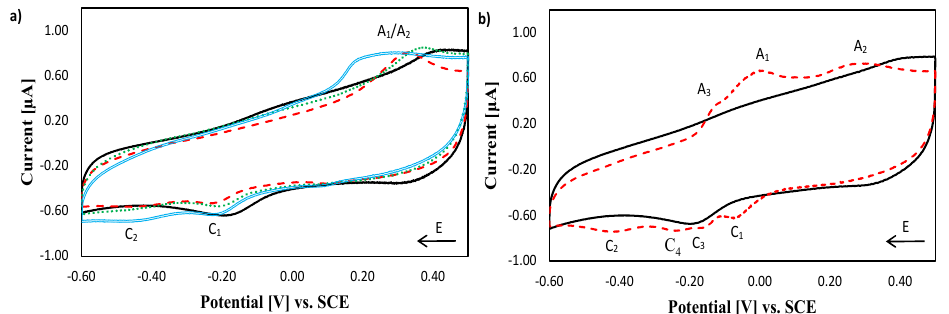
Figure 1. Typical cyclic voltammograms registered in O 2 -free solutions at the bare gold electrode, scan rate 100 mV s − 1 , in 0.1 M PB, pH 7.0 (black solid trace): ( a ) 20 µ M of [Cu(TPMA)(phen)] 2+ (red dashed trace), [Cu(TPMA)(bipy)] 2+ (blue double trace) and [Cu(TPMA)(DPQ)] 2+ (green dotted trace), ( b ) 20 µ M of [Cu(TPMA)(PD)] 2+ (red dashed